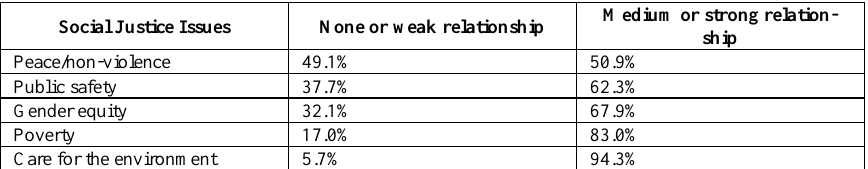
Table 2. Relationship between engineering and social justice